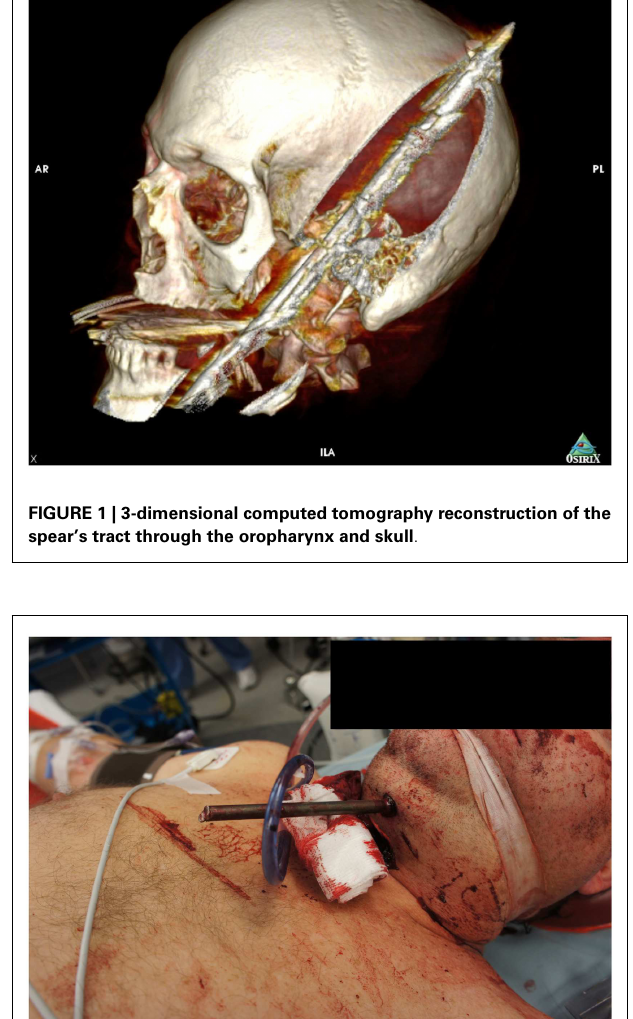
FIGURE 2 |View of the cut tail of the spear protruding from the patient’s neck before removal .